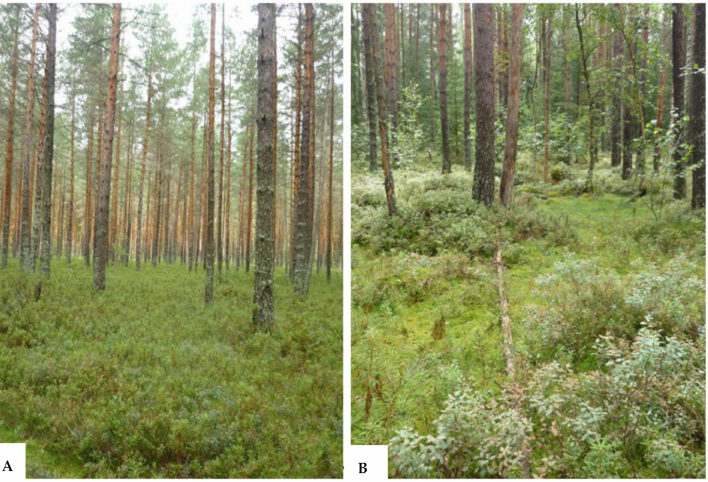
Figure 5. ( A )—Pine dwarf shrubs-sphagnum forest, ( B )—Pine dwarf shrubs–herbal-sphagnum forest, spruce-in the undergrowth (layer B) on the border of hydromorphic habitat (Photo by